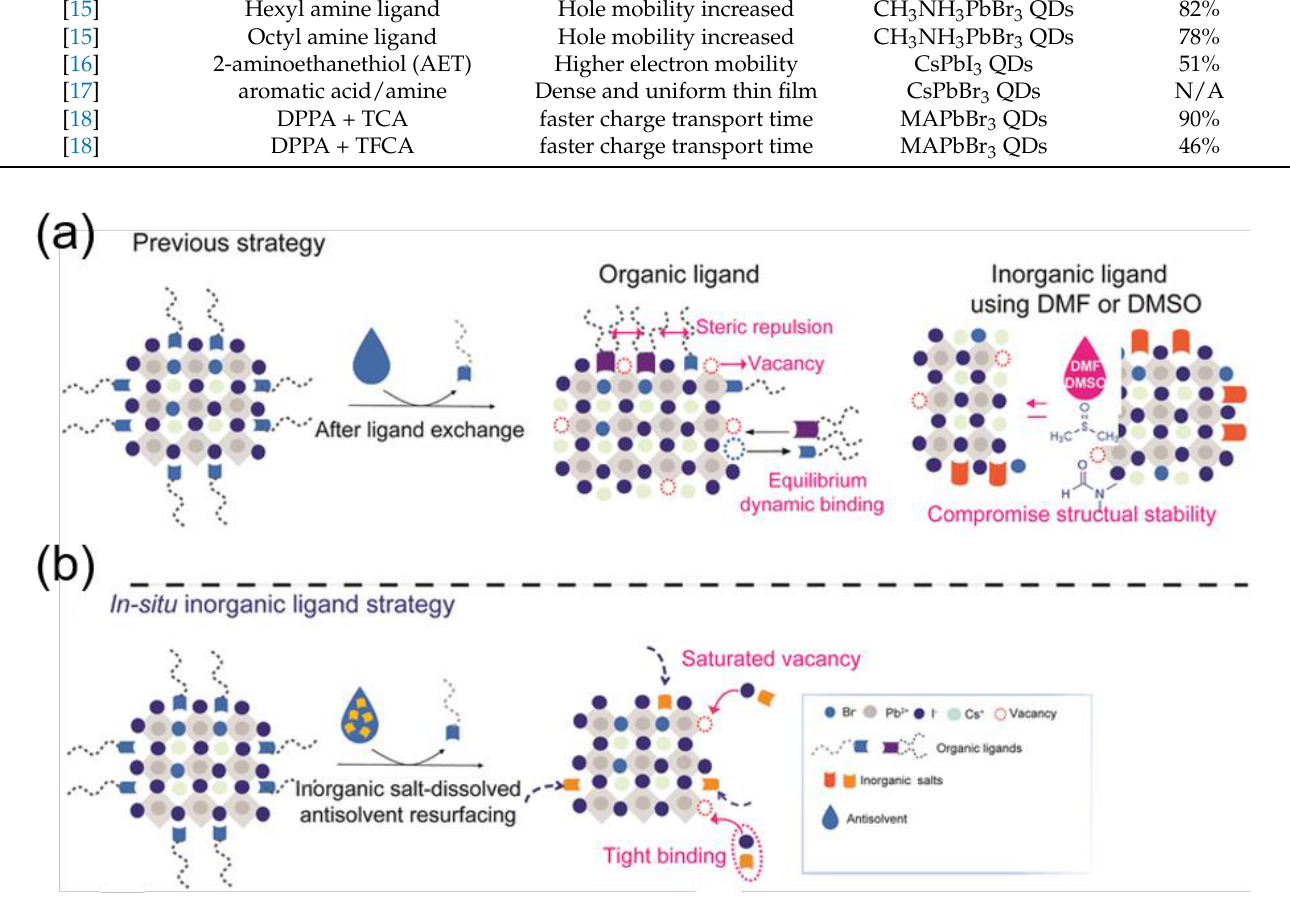
Figure 2. Schematic of ( a ) previous strategy: organic ligands and inorganic ligands were introduced using highly polar solvents; ( b ) in situ inorganic ligand strategy: inorganic ligands were introduced using a mildly polar antisolvent, such as ethyl acetate in this work [14]. Copyright 2022 John Wiley & Sons, Inc. Table 1. Result of perovskite film after ligand exchange. KI inorganic ligand increased the mobility from 9 × 10 – 4 cm 2 V – 1 s – 1 to 6 × 10 – 2 cm 2 V – 1 s −1 [14]. Hexyl amine ligand and octyl amine ligand can